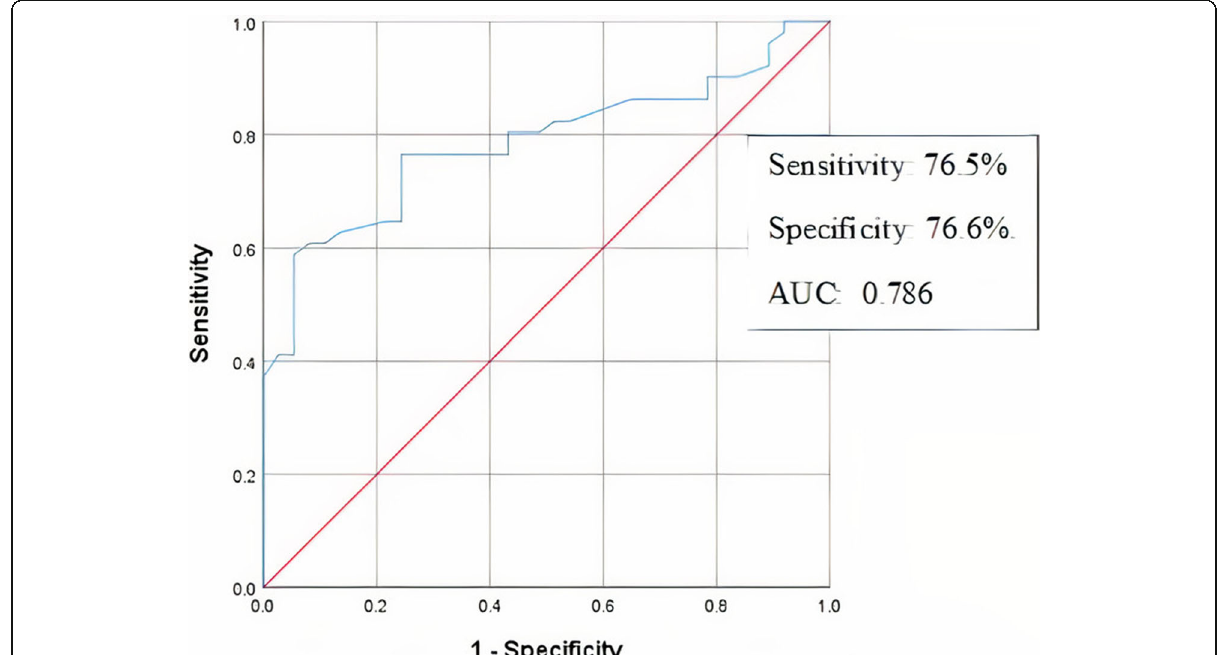
Fig. 5 Receiver operating characteristic (ROC) curve analysis (global longitudinal strain ≥ − 19.25 may be useful to detect coronary artery